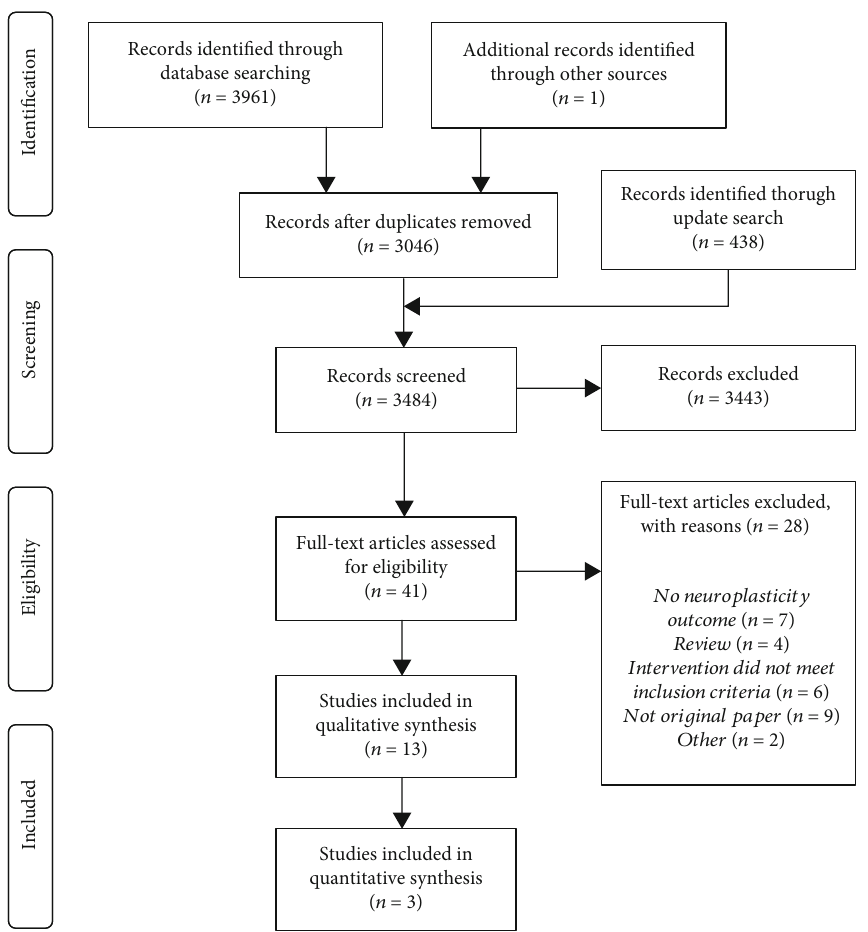
Figure 1: PRISMA fl ow diagram modi fi ed from Moher D, Liberati A, Tetzla ff J, Altman DG, The PRISMA Group (2009). Preferred Reporting Items for Systematic Reviews and Meta-Analyses: The PRISMA Statement. PLoS Med 6